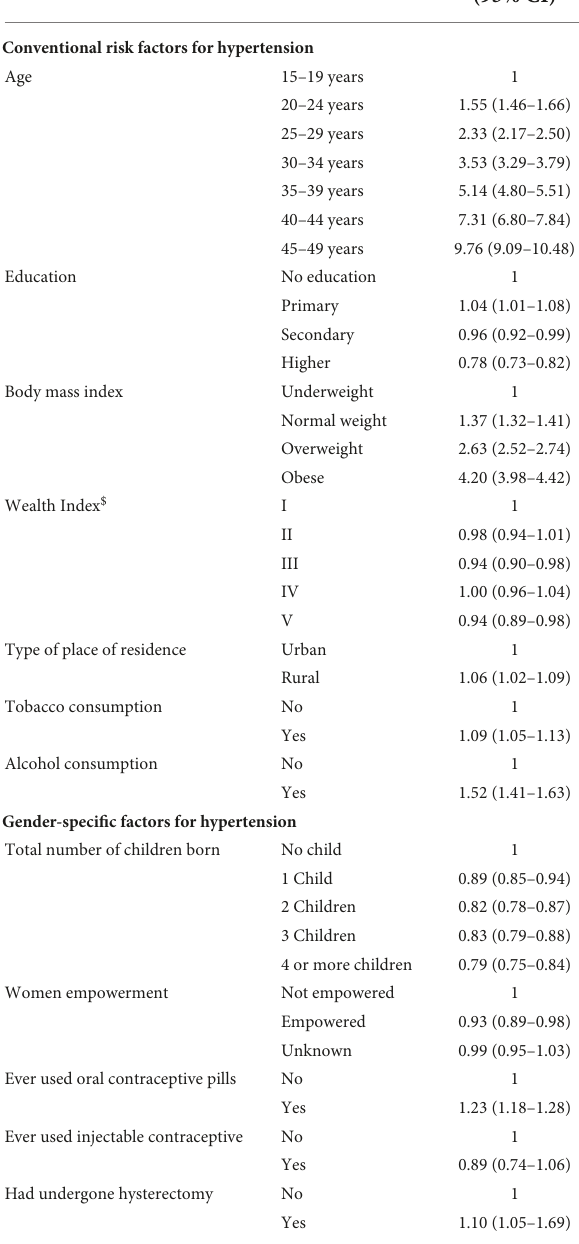
TABLE 3 Multivariate regression analysis of conventional and other gender-specific factors for hypertension among women of age 15–49